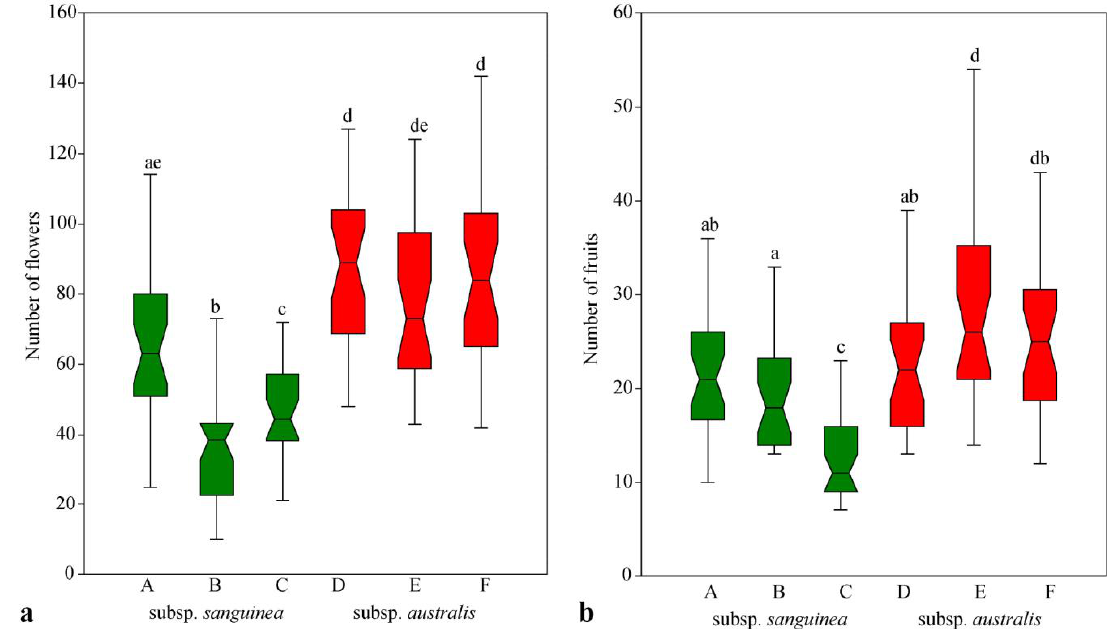
Figure 3. Comparison of the number of flowers ( a ) and the number of fruits ( b ) at the study sites of Cornus sanguinea subsp. sanguinea (A — Piepaliai; B — Veliuona; C —Šilinė) and Cornus sanguinea subsp. australis (D —Maišiagala; E—Ginkūnai; F—Kaišiadorys) . Different lower-case letters